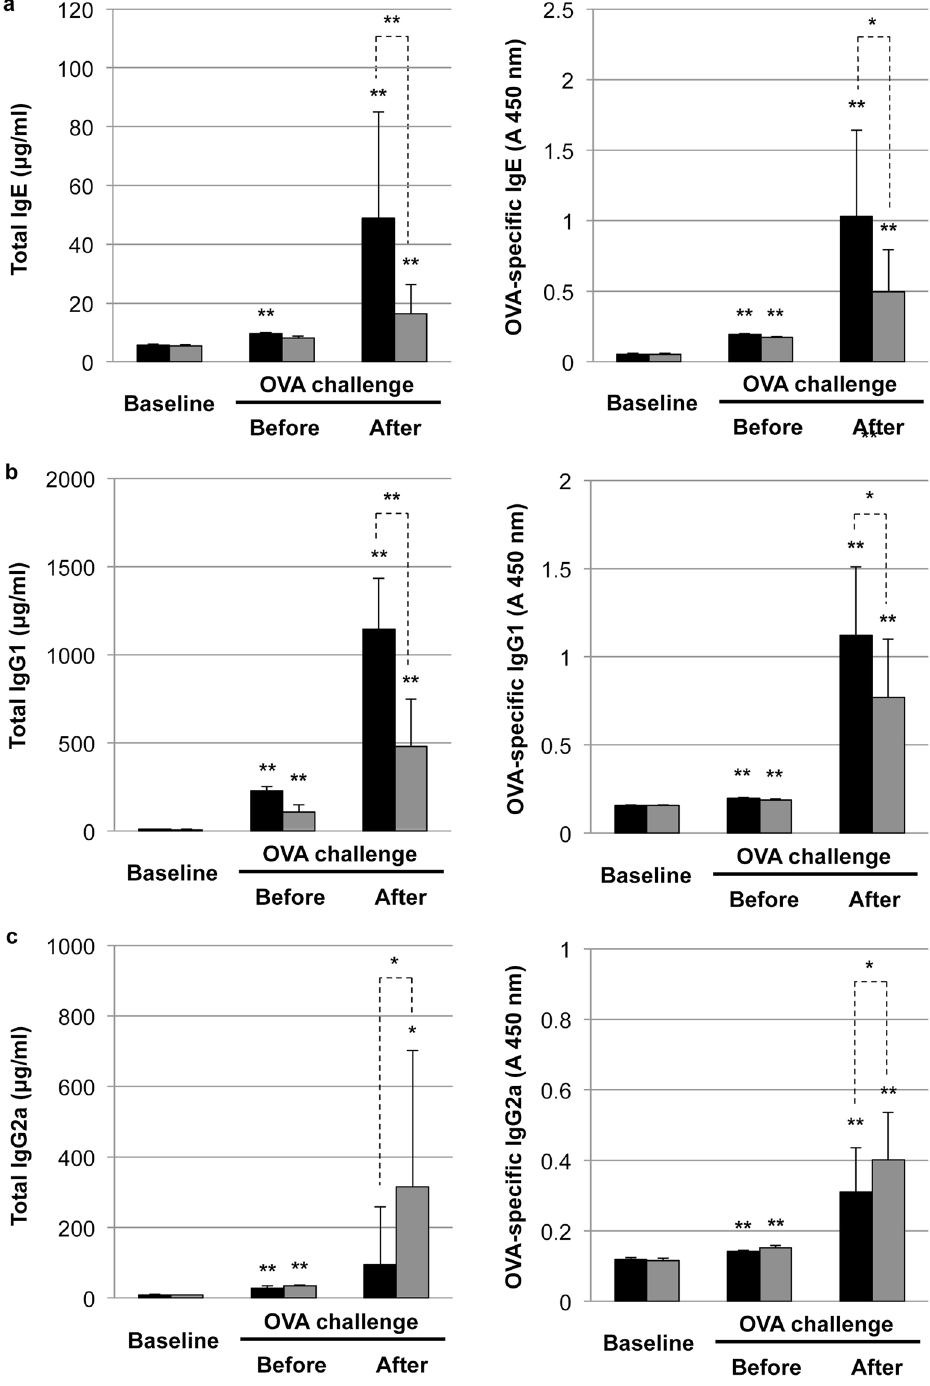
Fig. 2 Impact of phototherapy on immunoglobulin production in food allergy (FA). Serum levels of total or OVA-speci fi c IgE ( a ), IgG1 ( b ), and IgG2a ( c ) in the FA (black bar) and phototherapy (gray bar) group were measured by ELISA. Values are presented as the mean ± SD of at least eight individuals in each group. *, **, P < 0.05 and 0.01 vs. baseline or the phototherapy group, respectively (Student ’ s t